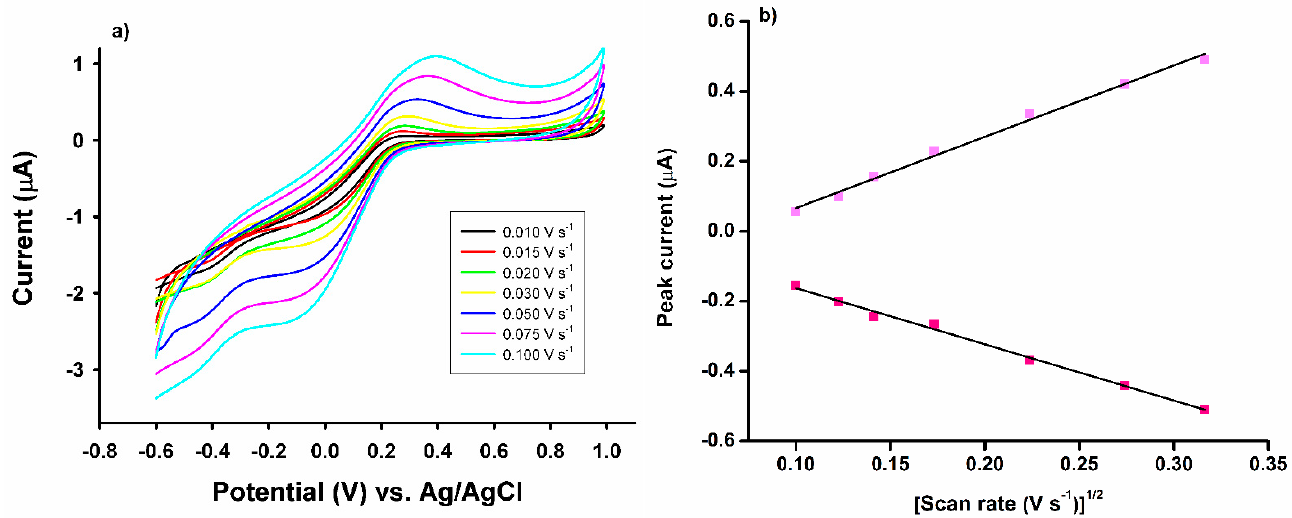
Figure 3. ( a ) CVs in a solution of 5.0 × 10 − 3 mol L − 1 K 3 [Fe(CN) 6 ] (0.1 mol L − 1 KCl) at various scan rates ranging from 0.010 to 0.100 V s − 1 using the PIX/AuNPsnGr sensor (working conditions: potential range from − 0.6 to 1.0 V; step potential 0.025 V). ( b ) Dependence of the peak current on the square root of the scan rate for the PIX/AuNPsnGr sensor .